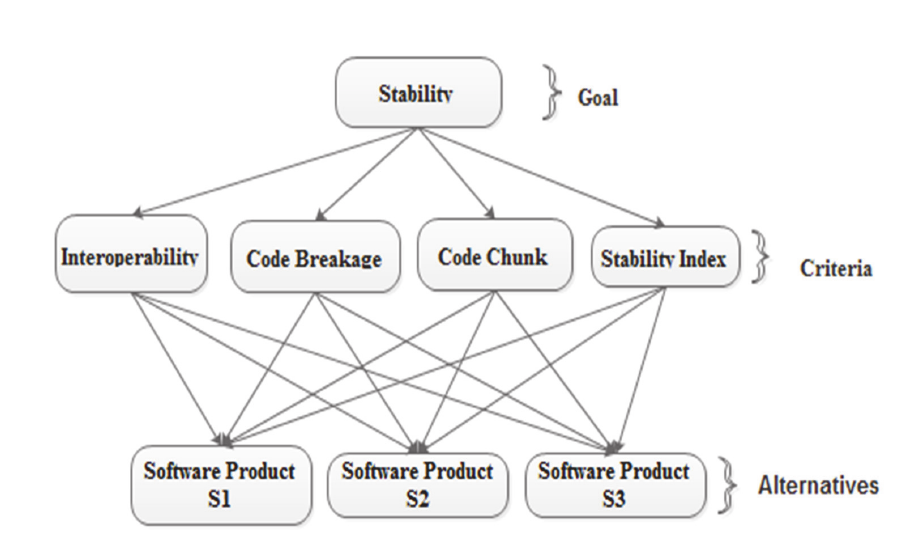
Fig. 6. Hierarchical Structure of